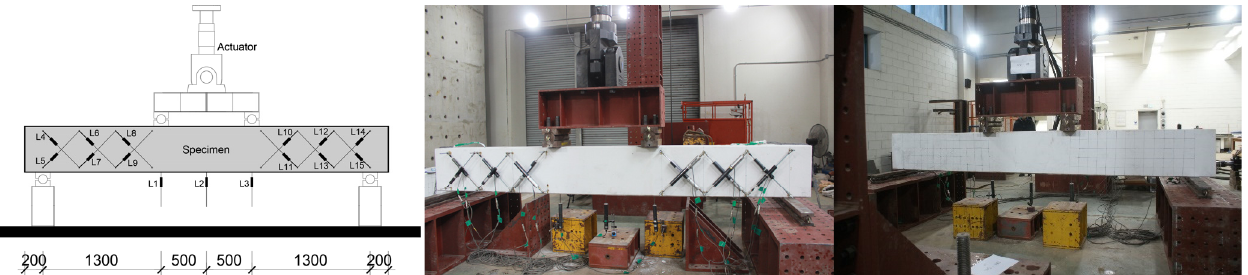
Figure 4. Loading test configuration [unit: mm].